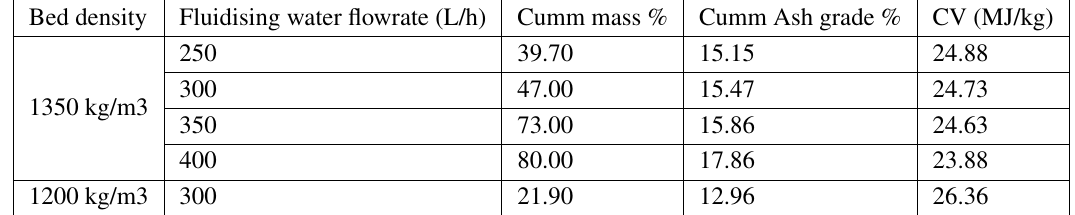
Table 7. Reflux classiffier test results